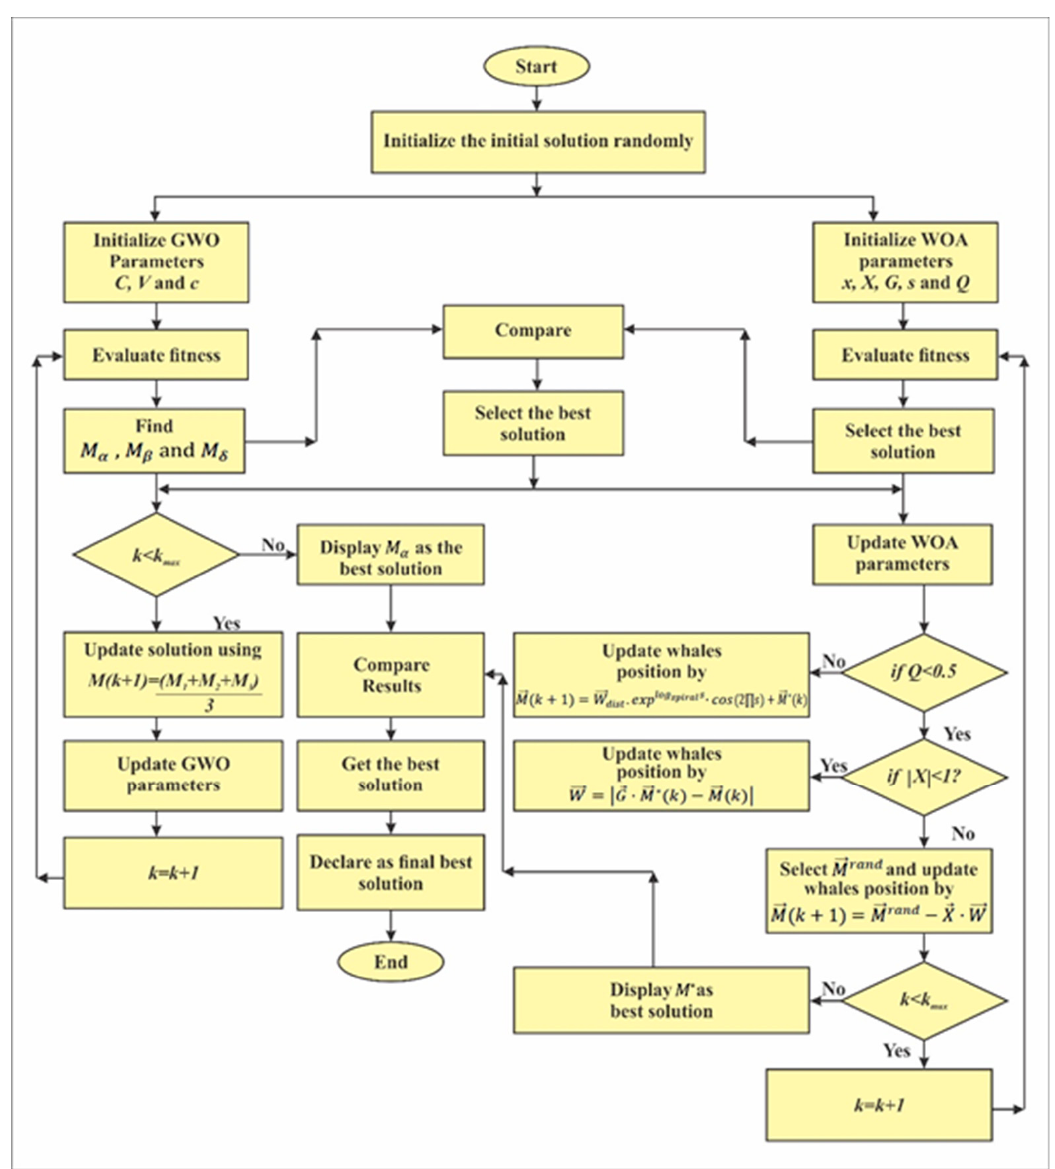
Figure 1. Flowchart of the proposed adapted whale optimization for the green underwater network (W-GUN).